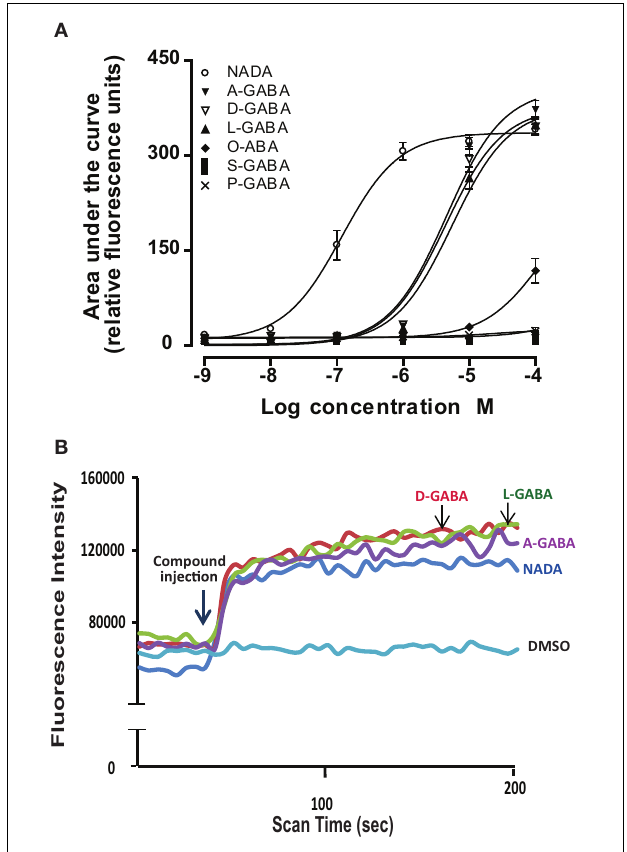
FIGURE 2 | Individual N -acyl GABA species drive calcium in TRPV1-transfected HEK cells. (A) Concentration curves of individual N -acyl GABA: N -docosahexaenoyl GABA (D-GABA), N -arachidonoyl GABA (A GABA), N -linoleoyl GABA (L GABA), N -oleoyl GABA (O GABA), N -palmitoyl GABA (P GABA) and N -stearoyl GABA (S GABA) compared to the potent TRPV1 agonist, N-arachidonoyl dopamine (NADA). (B) Flourescence intensity that is an indication of calcium mobilization as measured by the ratiometric calcium-sensitive dye FURA2am in response to D-GABA, A GABA, L GABA, NADA, and the vehicle, DMSO. Data were generated in a Flexstation II (Molecular Devices).